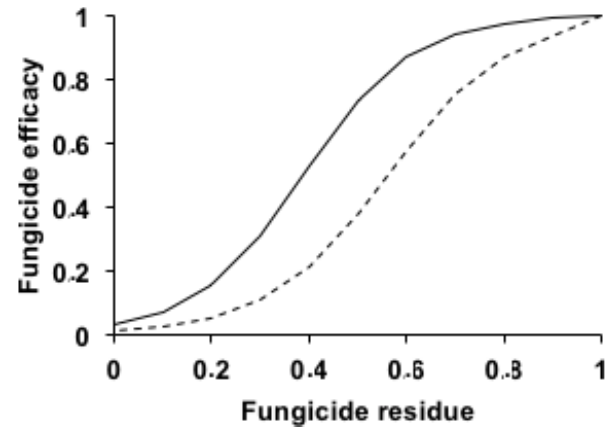
Figure 4. Relationship between fungicide residue remaining and efficacy as calculated by equation EF t = EF 0 / [1 + exp (a – b × C t )] [5]. The following equation parameters were used in this example: EF 0 (fungicide efficacy at the time of application, day 0) = 1, a = 3.5, b = 9 (solid line); EF 0 = 1, a = 4.5, b = 8 (dotted